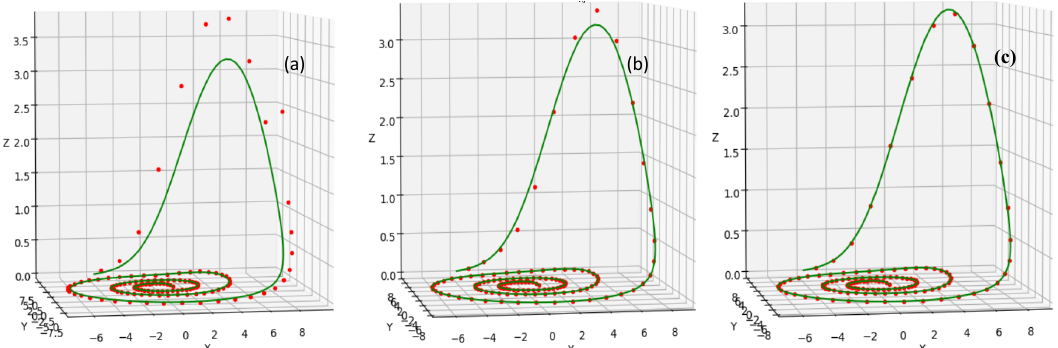
Figure 7. Showing the effect of iterations on the convergence towards the solution of the Rössler Equation (17). The green line is showing the expected solution, and the red dots are showing the PAMCL estimation at different iteration steps. For all 3 sub-figures (i.e., from left to right), the same parameter settings were used but 25 points are used in Sub-Figure ( a ), 50 points are used in Sub-Figure ( b ), and 100 points are used in Sub-Figure ( c ). Those points are calculated in a parallel way. It is visible that the estimation of model is changing from the expected results and an increasing number of does increase the model accuracy, but does also increase the calculation time.